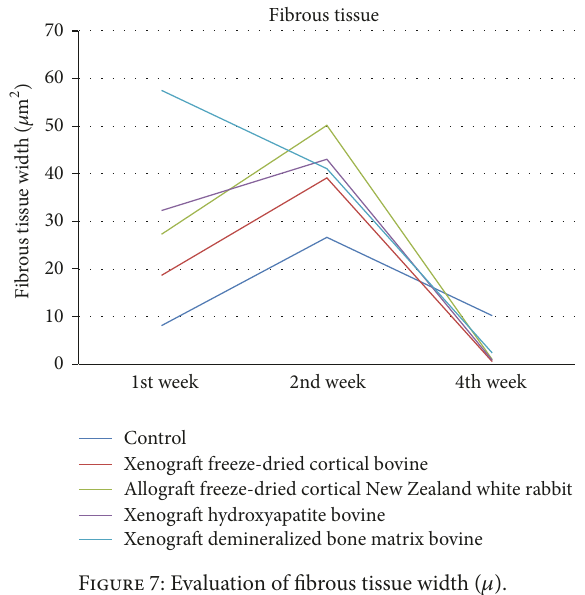
Figure 5: Evaluation of osteoclast/ 𝜇 m 2 .